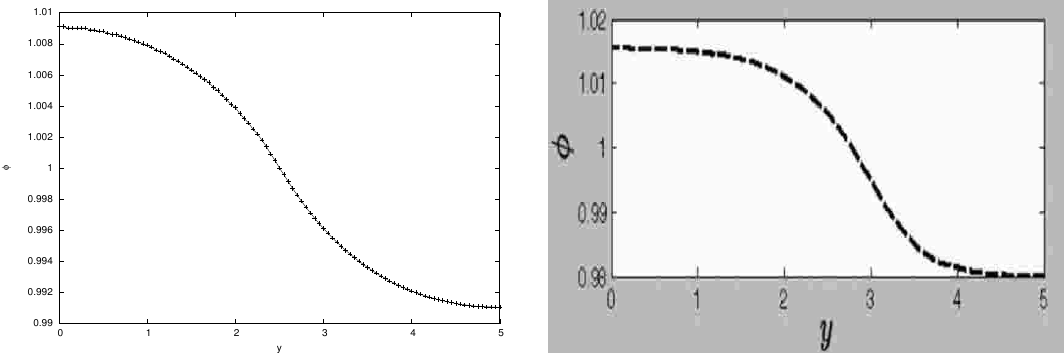
Figure 11. Concentration profile φ for k = 1 using the DEVSS method (LHS) (compared with references [31] (RHS)).